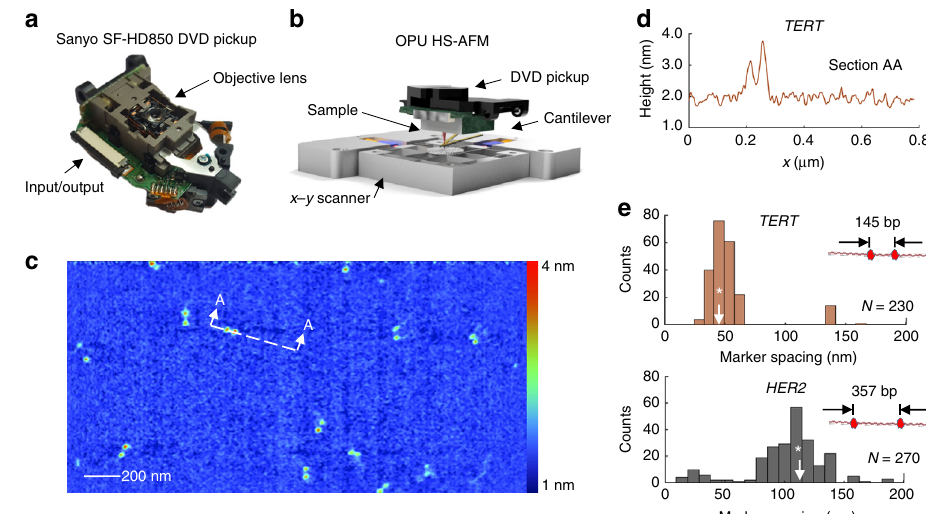
Fig. 5 Detecting Cas9 labels with a DVD player part used as a displacement sensor. a Photo of the DVD player optical pickup unit showing the location of the laser-focusing objective and the signal and control connection point. Behind the objective lens is the 650-nm-wavelength diode laser, quadrant photodiode, and associated optics. b Schematic of the HS-AFM scan stage with the DVD optical pickup used as the cantilever displacement sensor. c An example image of TERT amplicons labeled with two Cas9 proteins. This image was obtained by averaging fi ve full frames collected at the maximum frame rate of 2 frames per second. d Typical height cross section from double-labeled molecules obtained with the DVD optical pickup. e Histograms of Cas9 marker spacing measured for populations of TERT and HER2 molecules. The white asterisk indicates the expected